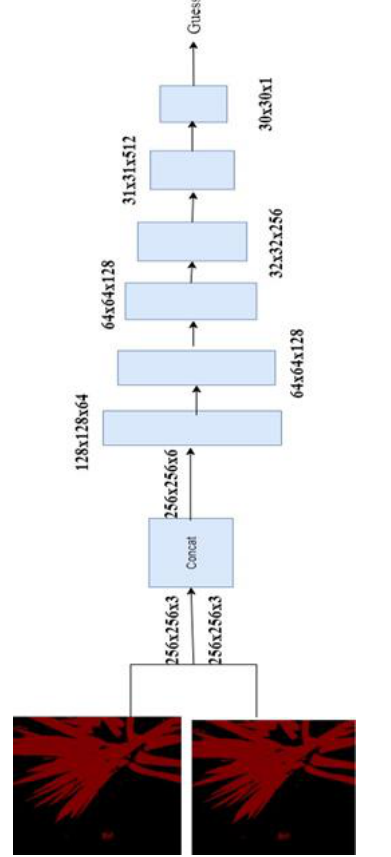
Figure 6. Network architecture of PatchGAN Discriminator . One of the two images is the analyst annotated image, while the second image is created by the Generator . These images are passed through a series of filters of different kernel size and numbers for feature extraction and comparison.